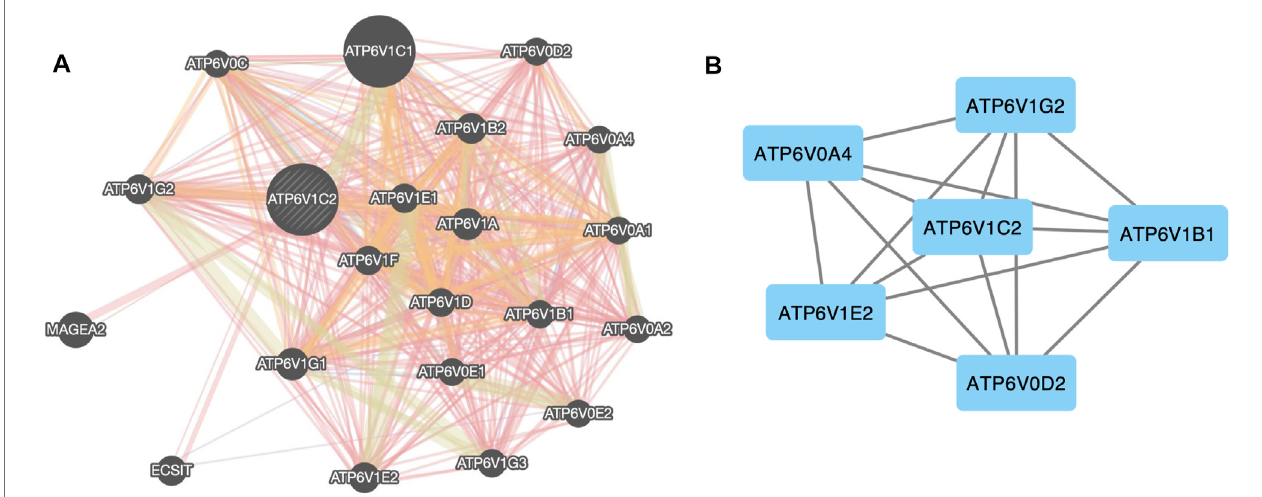
FIGURE3| Protein – proteinnetworkofATP6V1C2. (A) Protein – proteinnetworkbetweenATP6V1C2andtop20co-expressedgenespredictedfromGeneMANIA database; (B) Protein – protein network between ATP6V1C2 and DEGs in COAD among these top 20 genes. DEG: differentially expressed gene; COAD: colon adenocarcinoma.